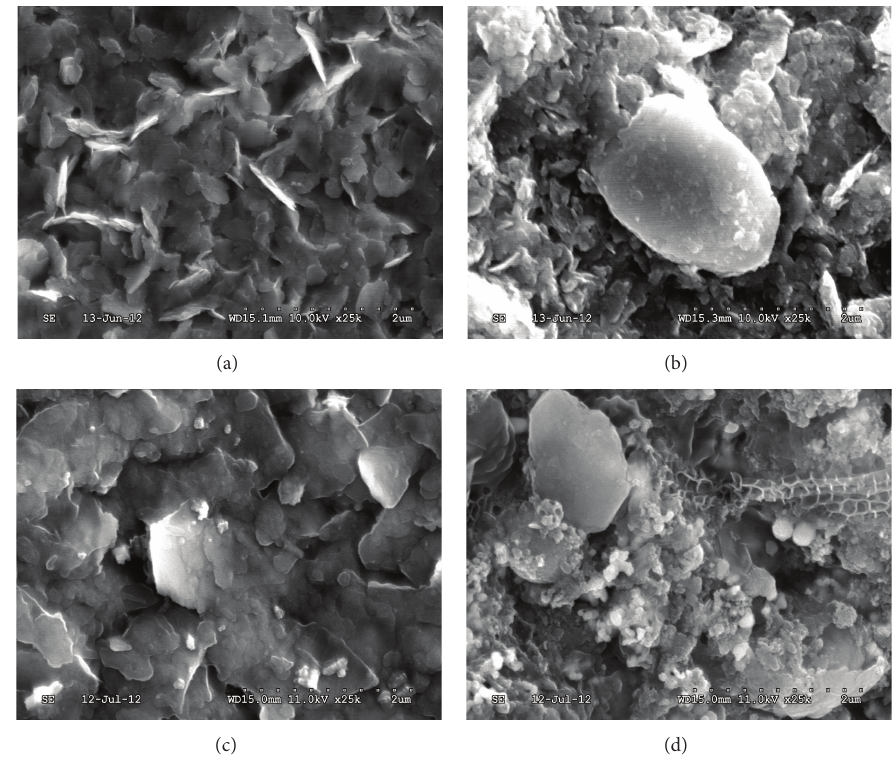
Figure 1: SEM images of the (a) smectitic, (b) mixed, (c) kaolinitic, and (d) biosolid macrocolloid aggregates.